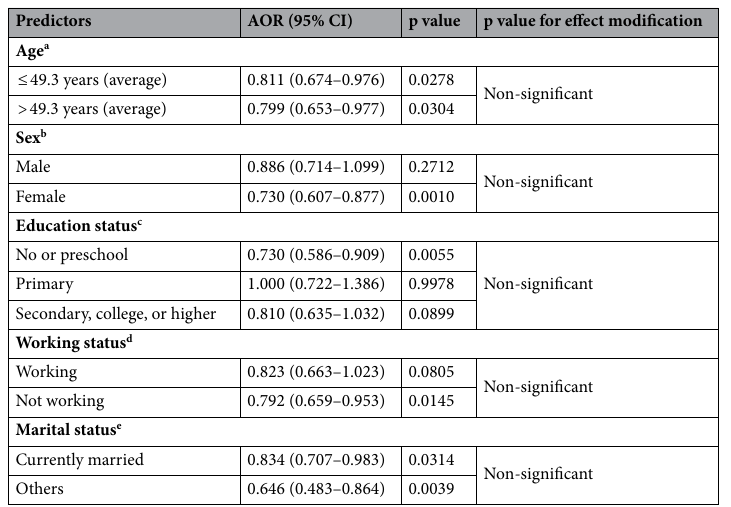
Table 3. Associations between residential area greenness (1 SD increase in EVI) and diabetes, stratified by sociodemographic variables. AOR adjusted odds ratio, CI confidence interval. a Adjusted for individual-level sex, education status, working status, and marital status; b Adjusted for individual-level age, education status, working status, and marital status; c Adjusted for individual-level age, sex, working status, and marital status; d Adjusted for individual-level age, sex, education status, and marital status; e Adjusted for individual-level age, sex, education status, and working status.